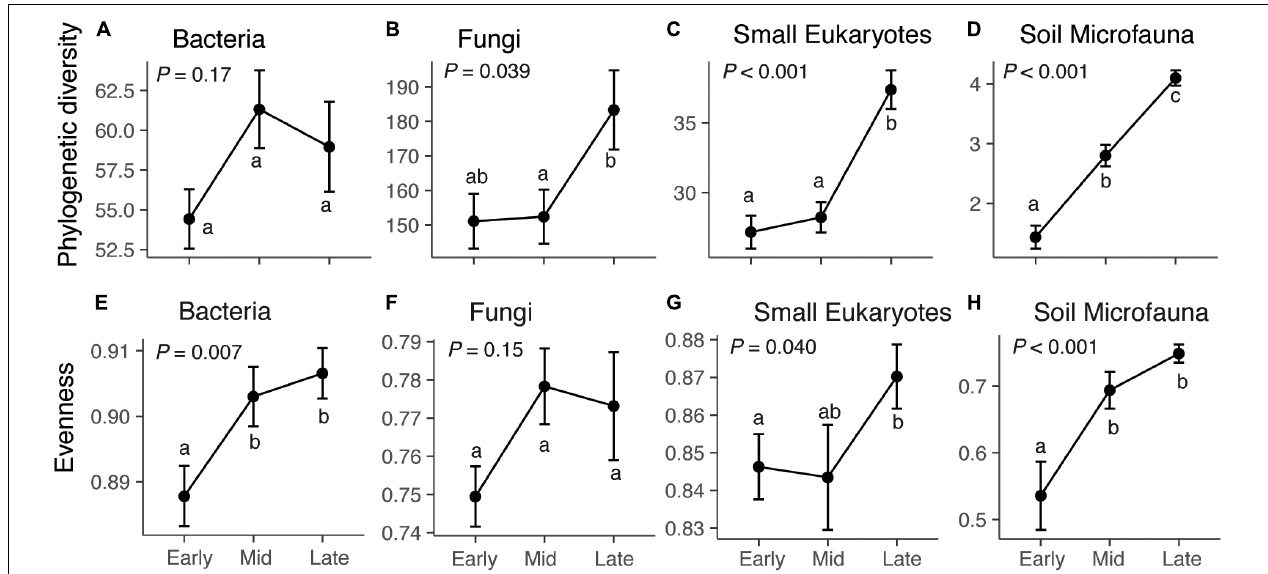
FIGURE 1 | Diversity and evenness of microbial communities across succession: bacteria (A,E) , fungi (B,F) , small eukaryotes (C,G) , and soil microfauna (D,H) . For bacteria, small eukaryotes, and soil microfauna, the diversity metric is Faith’s phylogenetic diversity, which is a measure of taxonomic richness. For Fungi, the metric is ASV richness (Chao1), since the ITS region cannot be aligned to give phylogenetic information. Successional stage does not have a significant effect on bacterial diversity ( F 2 , 72 = 1.82, P = 0.17), but does affect fungi ( F 2 , 72 = 3.41, P = 0.039), small eukaryotes ( F 2 , 72 = 21.01, P < 0.001), and soil microfauna ( F 2 , 72 = 54.23, P < 0.001). Successional stage affects evenness of bacteria ( F 2 , 72 = 5.28, P = 0.007), small Eukaryotes ( F 2 , 72 = 3.36, P = 0.040), and microfauna ( F 2 , 72 = 10.65, P < 0.001), but not fungi ( F 2 , 72 = 1.96, P = 0.15). Results of Tukey post hoc tests for comparing multiple treatments are shown as letters. Values shown are means and standard errors. Note that the y -axis scales are different for each taxonomic group.